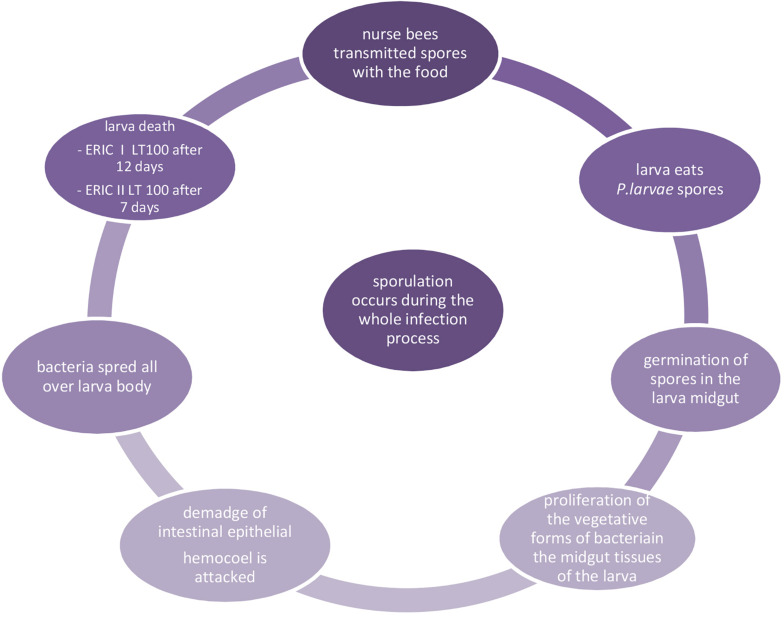
Infection cycle of AFB (Woodrow, 1942; Genersch et al., 2006; Yue et al., 2008).